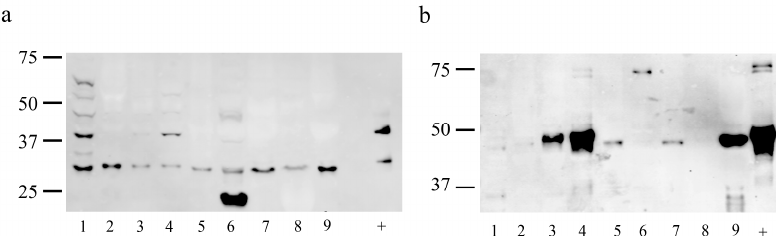
Figure 2. Western blot analysis of ( a ) MT 1 and ( b ) MT 2 in proteins obtained from various tissues of the ram reproductive tract: Testis (1), caput (2), corpus (3) and cauda epididymis (4), ampulla (5), prostate (6), seminal vesicles (7), bulbourethral glands (8), ductus deferens (9), and spermatozoa (+, positive control).